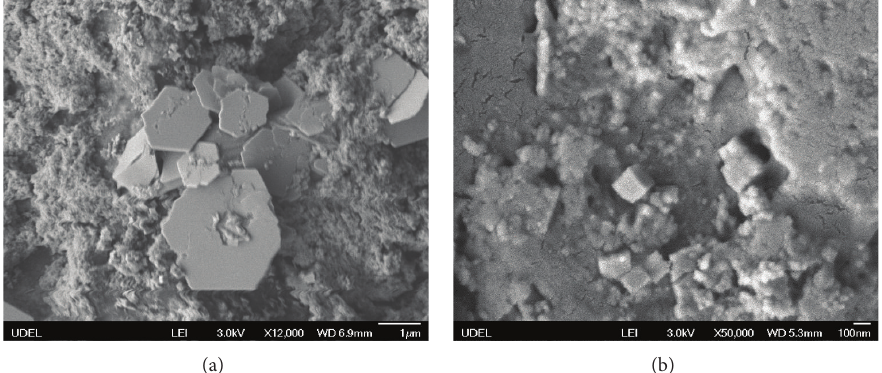
Figure 3: SEM morphology of PZT crystal in different reaction time (a) 10h; (b)